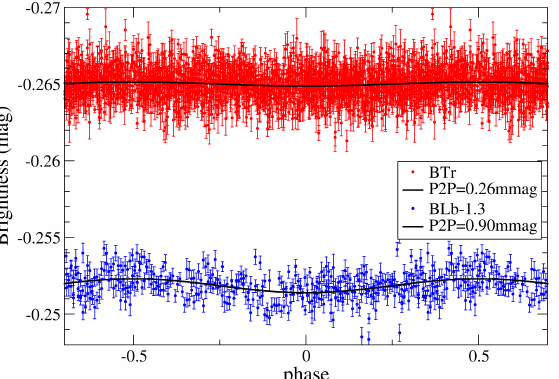
Figure 21. Phase plots for the red ( top ) and blue data ( bottom ) with the best-fit 10.1d period for Capella. The blue data are dominated by the hotter G0 component while the red data are dominated by the cooler G8 component. The rotation period of the cool component is near the orbital period of 104 days (adapted Figure3 of Strassmeier et al.